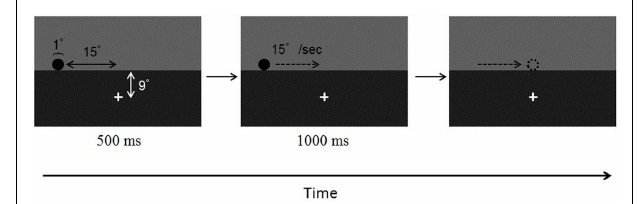
FIGURE 1 | Example of the visual display in Experiment 1.